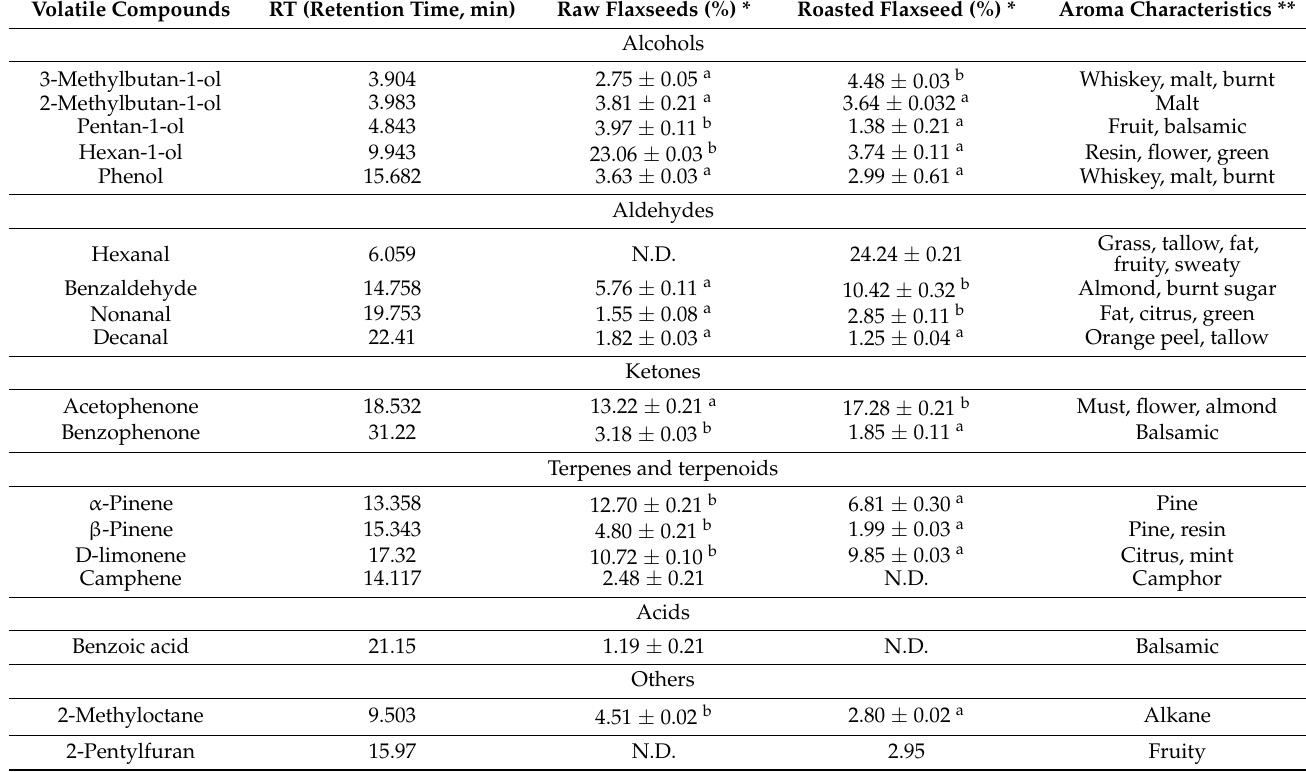
Table 3. Volatile compounds of raw flaxseeds and roasted